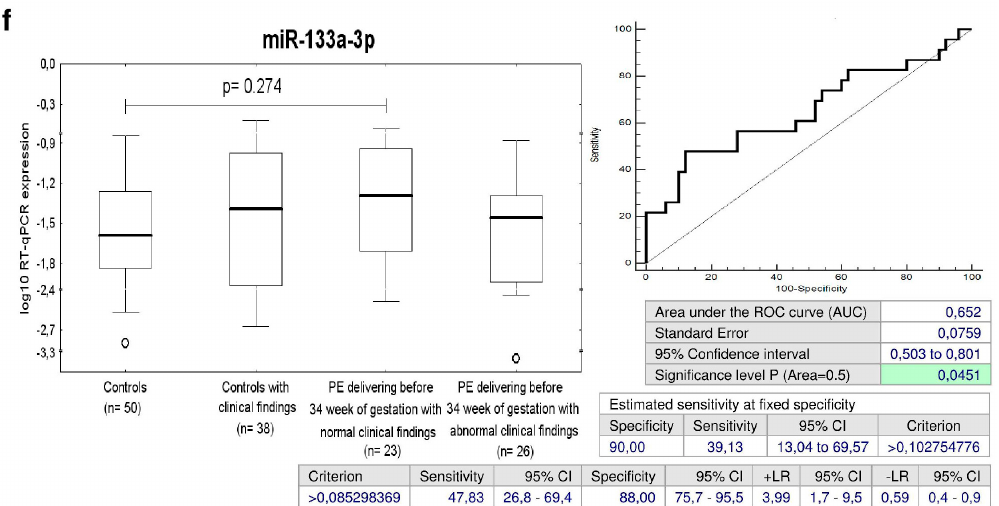
Figure 9. Increased expression of miR-133a-3p in children descending from PE pregnancies. ( a – c ) Increased expression of miR-133a-3p was observed in children descending from PE pregnancies regardless of the severity of the disease and delivery date, severe PE and late PE; ( d , e ) Increased expression of miR-133a-3p was found in children with both normal and abnormal postnatal clinical findings previously exposed to severe PE and late PE; ( f ) Increased expression of miR-133a-3p was found in children with normal postnatal clinical findings previously exposed to early PE.